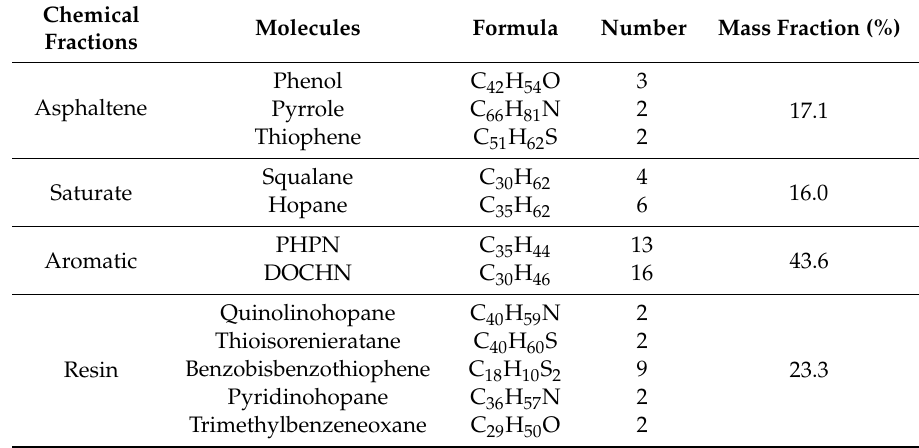
Figure 1. Chemical structures of 12 components in asphalt models. Table 1. Detailed compositions of saturates, aromatics, resins, and asphaltenes (SARA) components in the asphalt model.